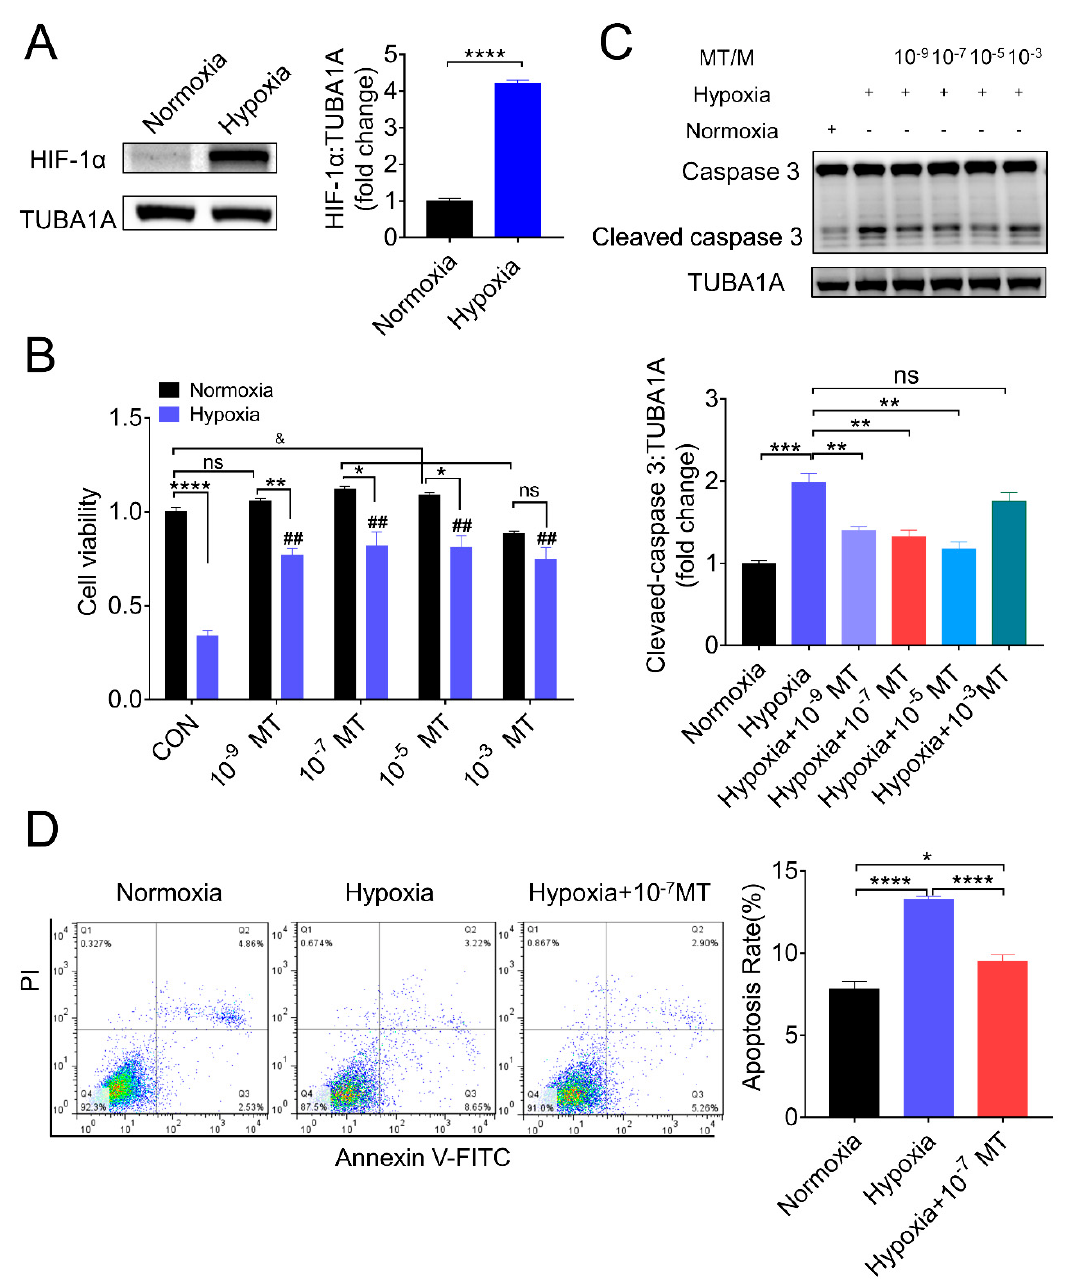
Figure 1. Effect of melatonin (MT) on porcine granulosa cells (GCs) viability and apoptosis during hypoxia. ( A ) The expression of hypoxia-inducible factor 1 α (HIF-1 α ) determined by Western blotting in GCs cultured in normoxia and hypoxia. ( B ) The cell viability of porcine GCs grown in normoxia and hypoxia in the presence of different concentrations of MT (0, 10 − 9 , 10 − 7 , 10 − 5 , 10 − 3 M). ( C ) The level of caspase − 3 and cleaved caspase − 3 determined by Western blotting in GCs grown in normoxia and hypoxia in the presence of different concentrations of melatonin (0, 10 − 9 , 10 − 7 , 10 − 5 , 10 − 3 M). ( D ) Flow cytometry analysis of the apoptosis of porcine GCs. * p < 0.05 was considered significant; ** p < 0.01 was considered highly significant; *** p < 0.001 was considered very significant; **** p < 0.0001 was considered extremely significant; ## p < 0.01 was considered highly significant; & p < 0.05 was considered significant; ns p > 0.05 was considered no